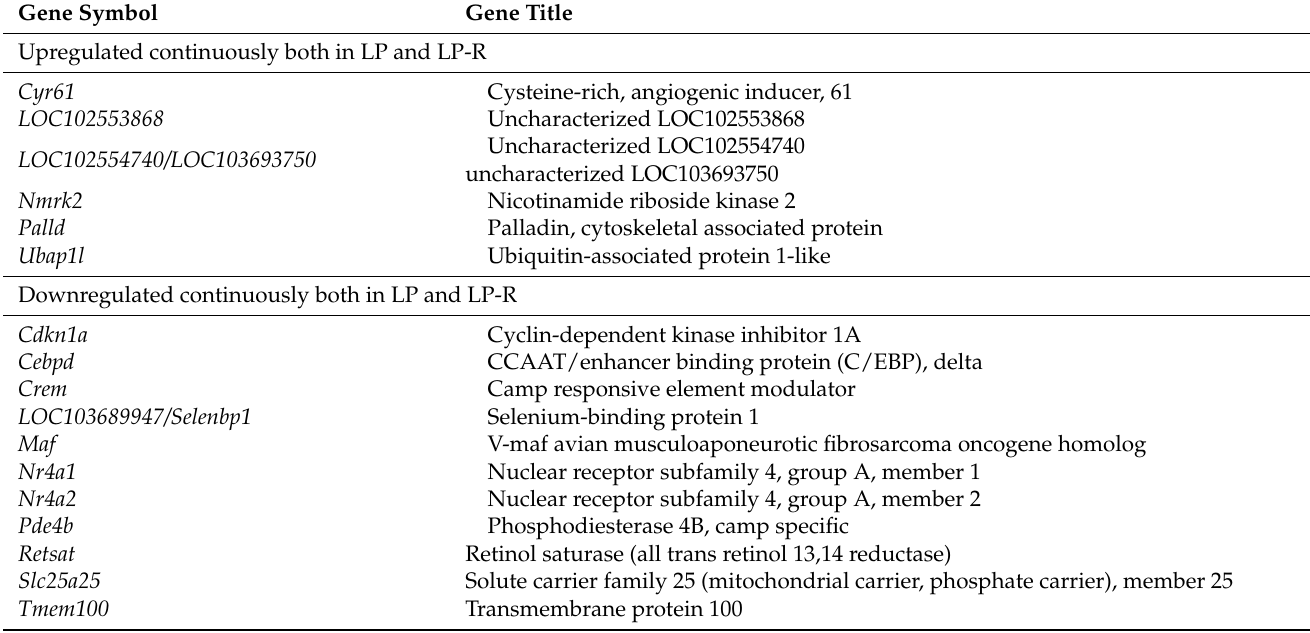
Table 4. Genes that are altered in LP and LP-R rats (Transcriptome